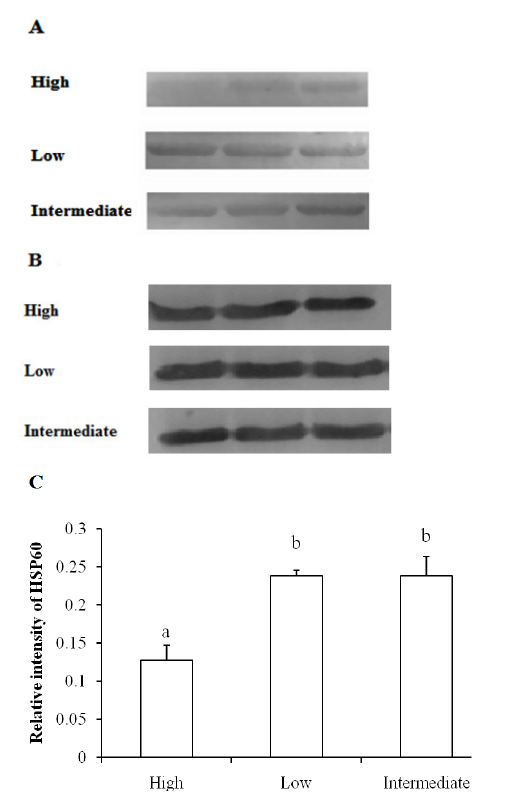
Figure 3. Western blot of heat shock protein (HSP) 60 (A), glyceraldehyde-3- phosphate dehydrogenase (B) in high (n = 6), intermediate (n = 6) and low (n = 6) drip loss grouped chicken muscles, and relative intensities of HSP60 (C). Error bars are standard error of the mean. Different letters indicate significant difference at p<0.05.